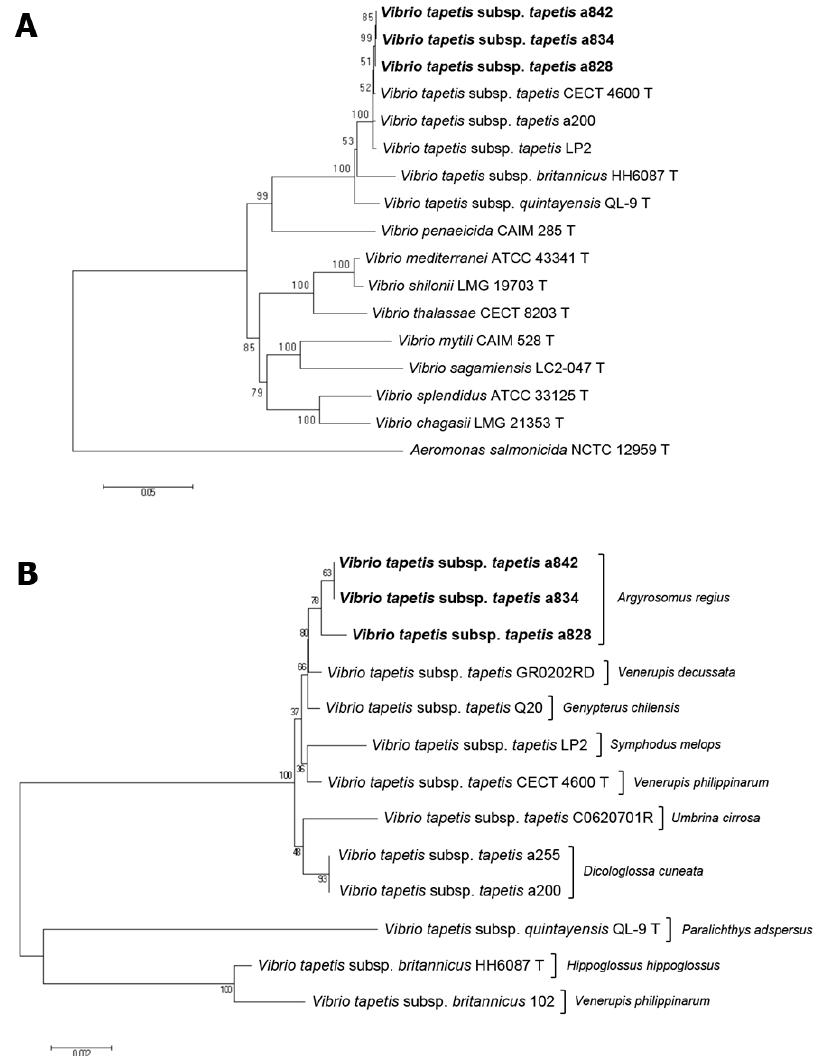
Figure 2. ( A ): Phylogenetic tree based on concatenated sequences of four housekeeping genes (16S rDNA, rpo D, rpo A and gyr B; 2948 nt) by the neighbor-joining method, showing the relationships between the isolates recovered from meagre (in bold), and related species of the genus Vibrio . ( B ): Phylogenetic tree based on concatenated sequences of three housekeeping genes (16S rDNA, rpo D and rpo A; 2435 nt), showing the relationships between Vibrio tapetis strains recovered from meagre and other host species. The numbers at the nodes indicate the levels of bootstrap based on 1000 replicates.